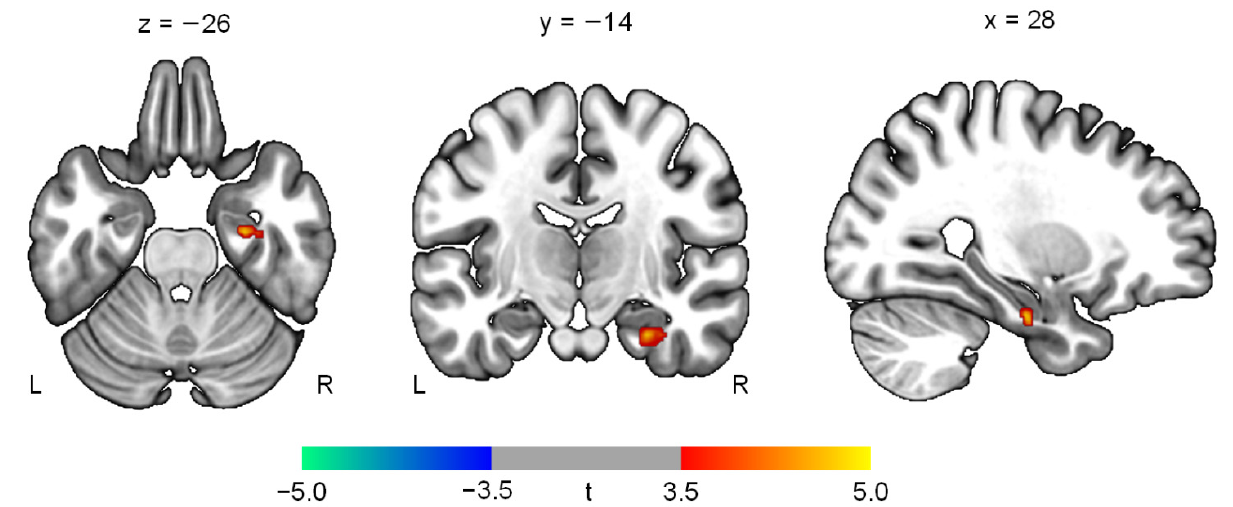
Figure 3. Changes in regional cerebral metabolic rate of glucose after transcranial focused ultrasound to the right hippocampus in patients with Alzheimer’s disease ( p < 0.005). The numbers above the slices indicate Montreal Neurological Institute coordinates. The color bar represents t values at each voxel. L, left; R, right.